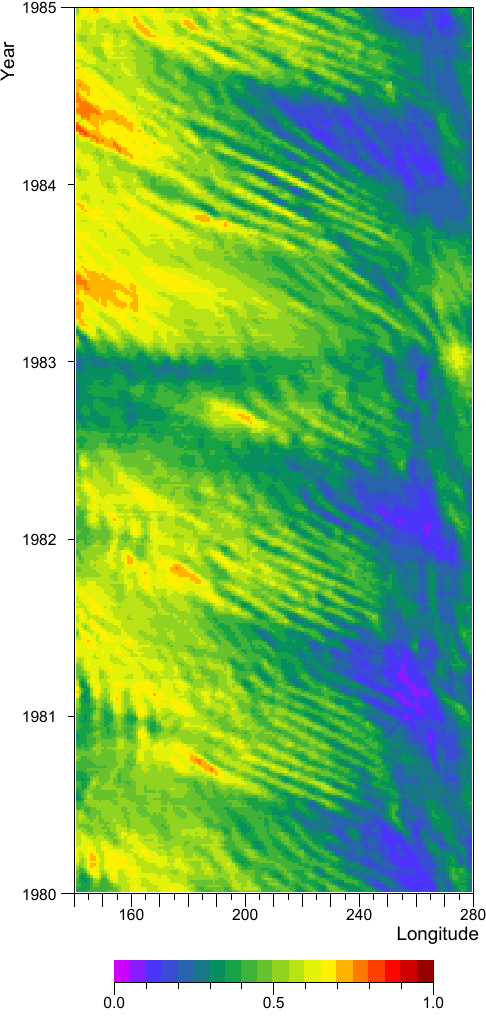
Figure 19. The model SSH (m) at the Equator as a function of time and longitude.